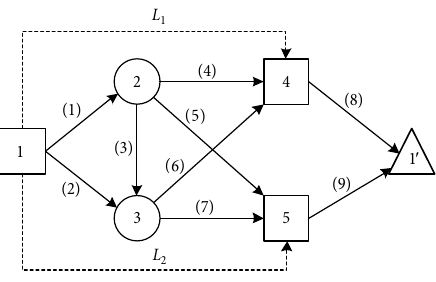
Fig. 3. Supernetwork for the test example